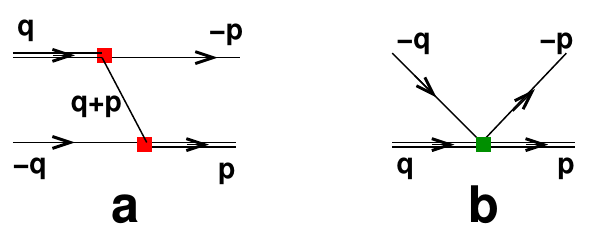
Figure 3 . The kernel of the three-particle Lippmann-Schwinger equation: a) the exchange diagram between the particle and the dimer; b) local particle-dimer interactions with couplings h 0 ; h 2 ; : : :